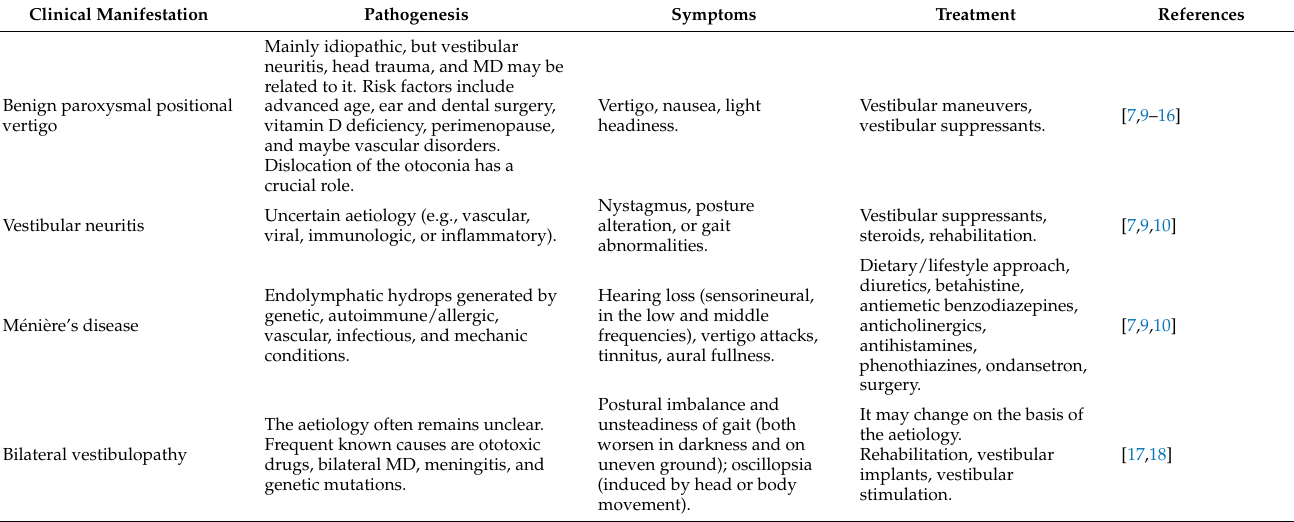
Table 1. Common cause of peripheral